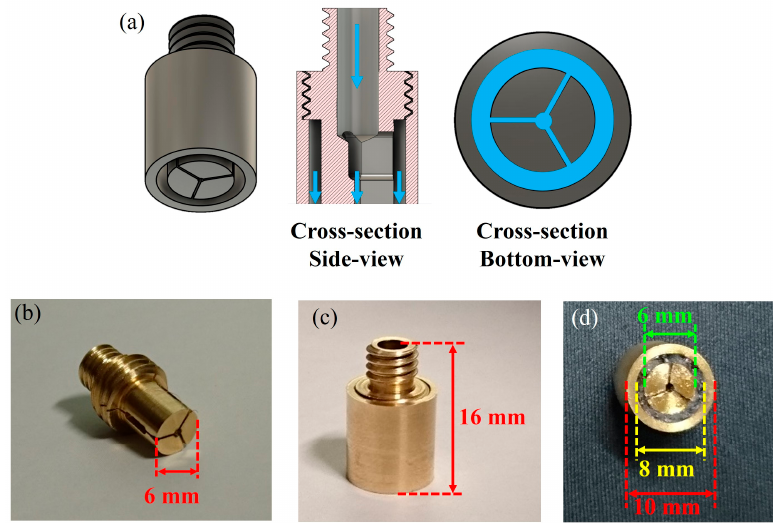
Figure 7. ( a ) Structured nozzle design. From left to right: a 3D model, cross-section of a side- and a bottom-view. Blue arrows represent the direction of polymer flow in the structured 3D printer’s nozzle. ( b – d ) Micromachined structured nozzle: ( b ) structured body, ( c ) body + cover, ( d ) after suspended-core (SC)-MPOF drawing [59] .